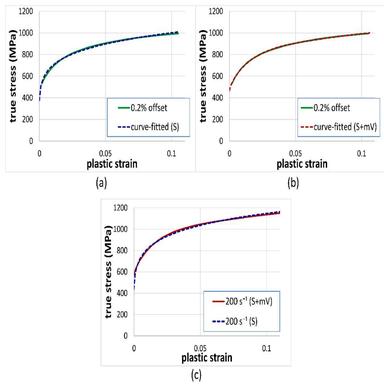
Effect of quasi-static hardening law: curve-fitting with (a) Swift and (b) combination of Swift and modified Voce (c) identified Lim-Huh curves at 200 s − 1 using the two hardening laws (DP780, S: Swift, S + mV: Swift and modified Voce).